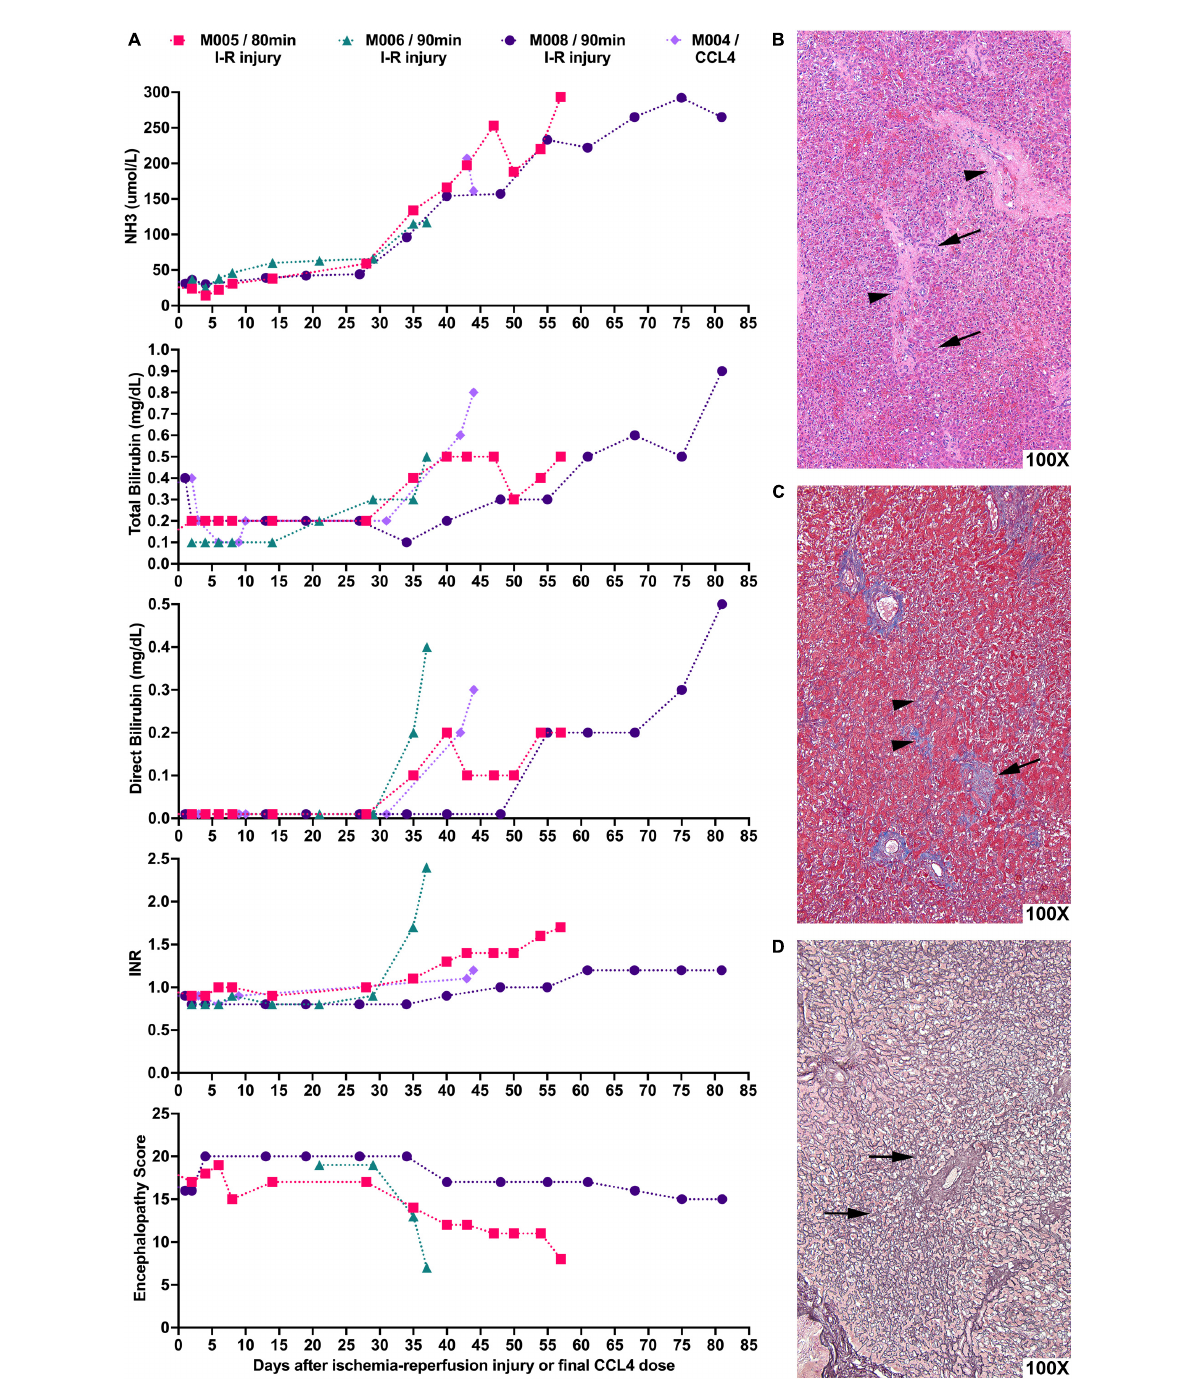
FIGURE2 Liver-directed radiation therapy in combination with hepatic ischemic-reperfusion leads to severe liver failure requiring euthanasia with histological hallmarks consistent with acute liver failure. (A) NHPs underwent liver-directed radiation therapy and, after 2 weeks, were subjected to 80–90 min of hepatic I-R injury (day 0). NH3, total bilirubin, direct bilirubin, and INR levels as well as encephalopathy scores of NHPs were recorded. Animals developed severe liver failure requiring euthanasia 10–12 days after key indicators of hepatic function begin to show abnormal levels. M004 is included for comparison of CCl 4 -induced ALF with the day of last CCl 4 dose set as day 0. (B) Representative photomicrograph of H&E stained liver sample showing extensive loss of hepatocytes with the collapse of the parenchyma leading to the approximation of portal tracts (arrowheads). Entire rows of hepatocytes have disappeared, leaving only a fraction of the original cells (arrows). (C) Representative photomicrograph of Masson’s trichrome staining of liver sample highlighting in blue the periportal collagen (arrow) and the interstitial fibrosis (arrowheads). (D) Representative reticulin staining of liver tissue showing that the fiber meshwork that normally lines each row of hepatocytes is now collapsed (arrows) as the intervening hepatocytes have died and